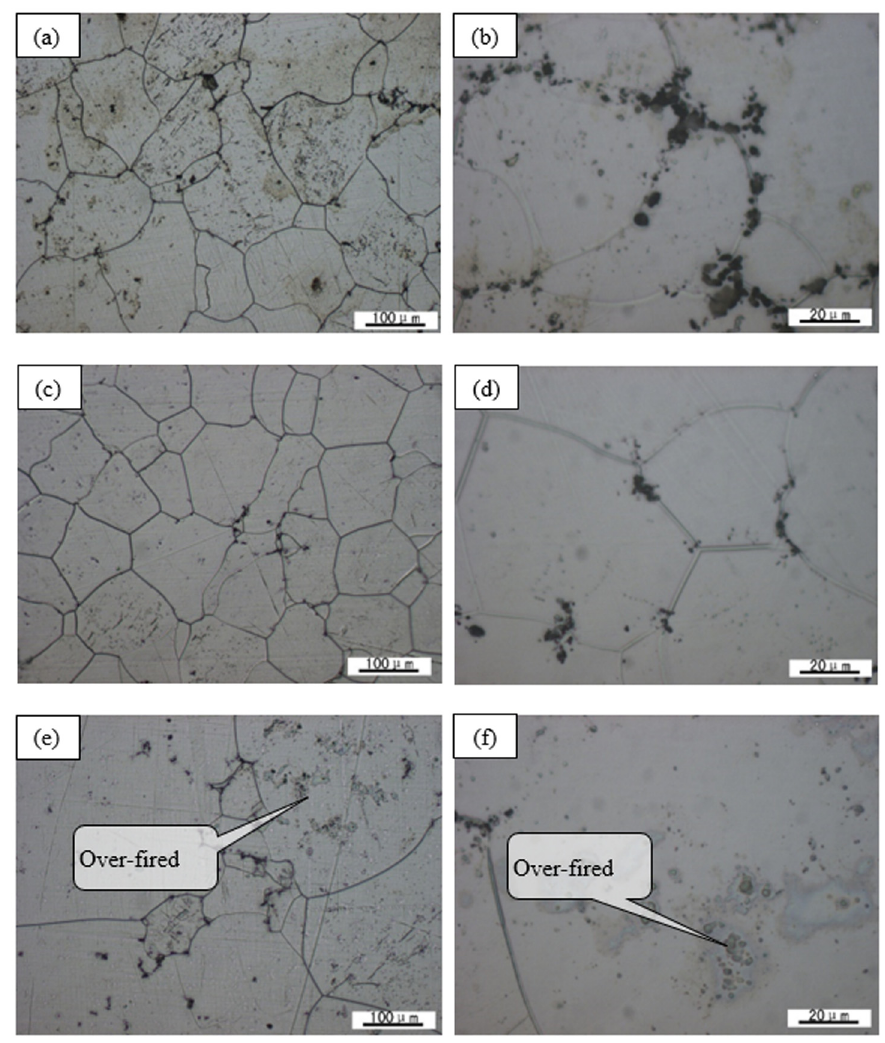
Figure 6. Optical microstructure of GWK-a alloy upon various homogenization temperature for 6 hs: ( a , b ) 480 °C; ( c , d ) 500 °C; ( e , f ) 520 °C.